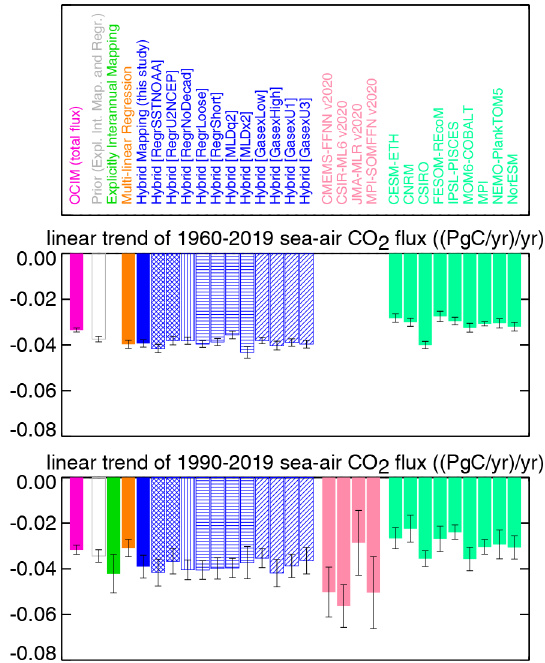
Figure A2. Secular linear trend of the global sea–air CO 2 flux over 1960–2019 (a) and over the more recent 1990–2019 period bet- ter constrained by p CO 2 data (b) , from the same estimates as in Fig. A1. The error bars give the formal error in the slope calculated from 5-year flux averages; i.e. they reflect the uncertainty due to the pentadal variability around the linear trend, thereby roughly taking into account the serial correlations of the flux, e.g. on the El Niño timescale.